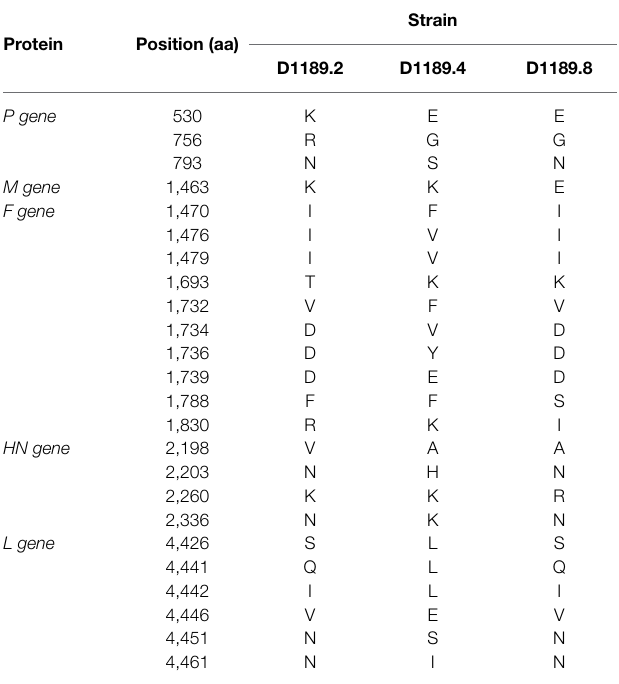
Protein Position